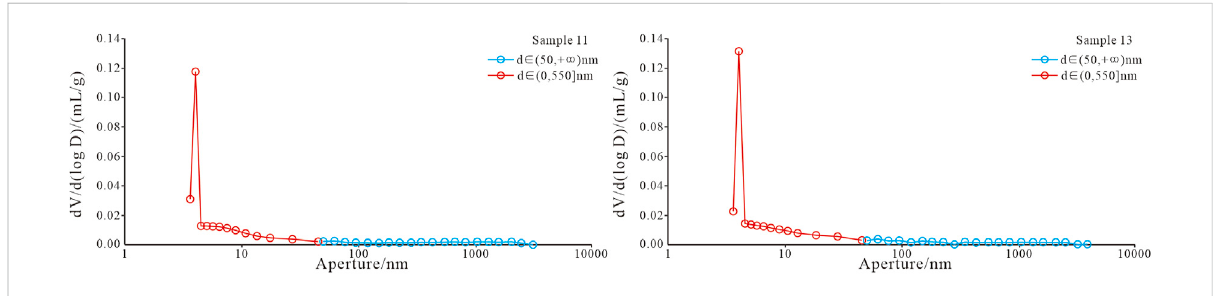
FIGURE 12 Multi-scale analysis of aperture distribution of Longtan